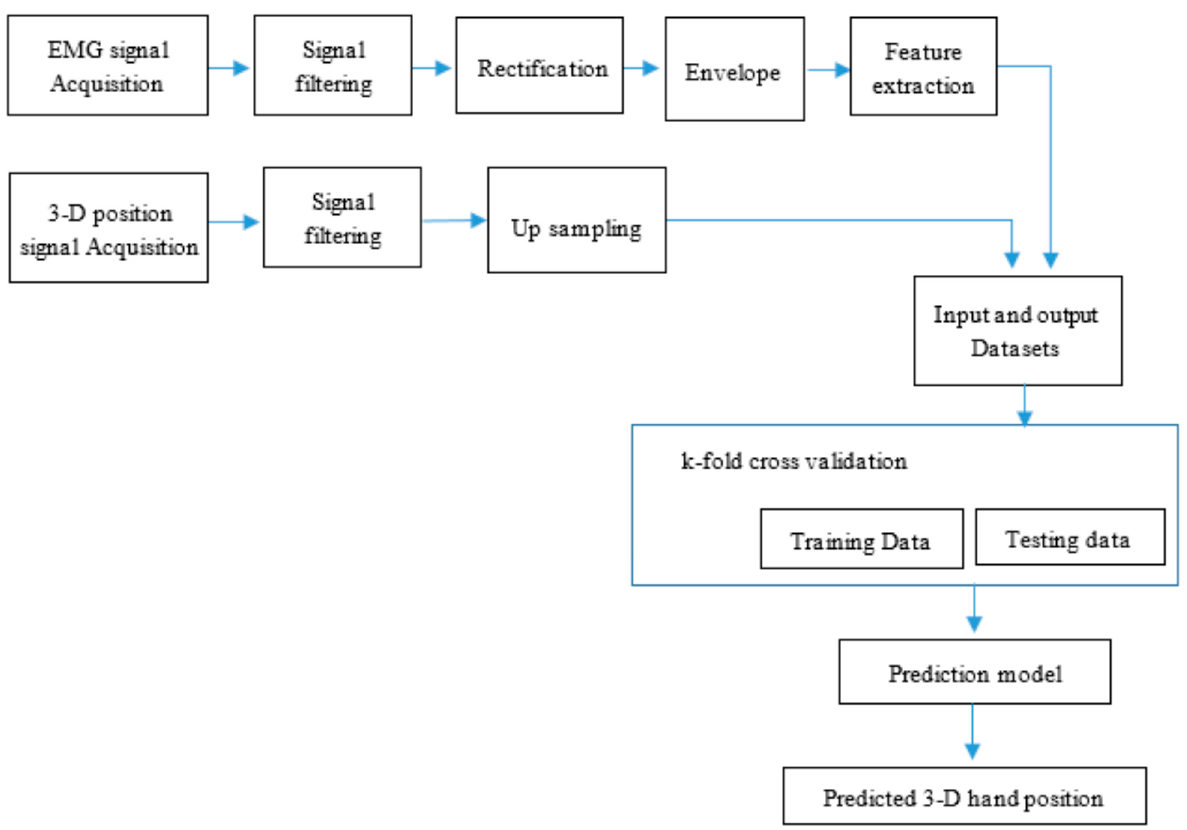
Figure 5. Flow diagram of the proposed method.